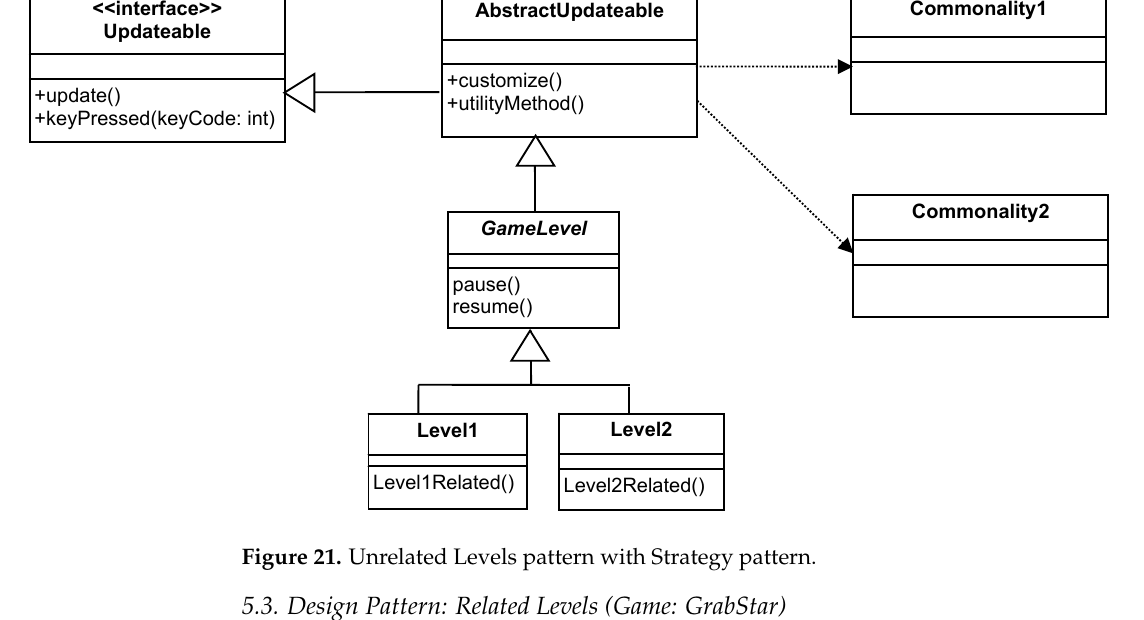
Figure 20: Different Levels of ShootDown Demo Game.